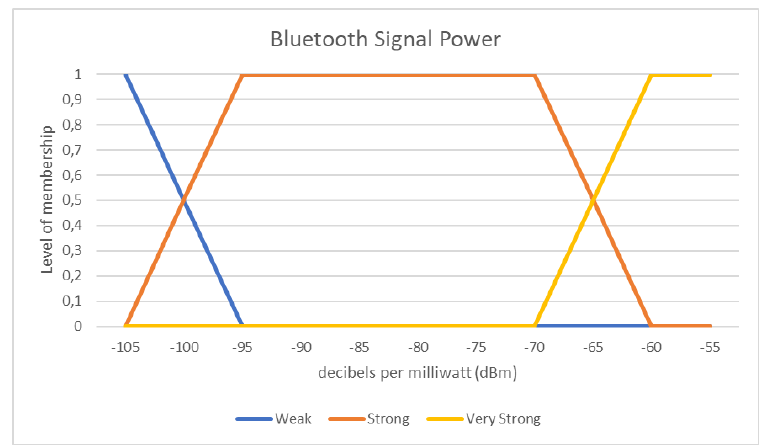
Figure 3. Fuzzy Sets Defined with Bluetooth